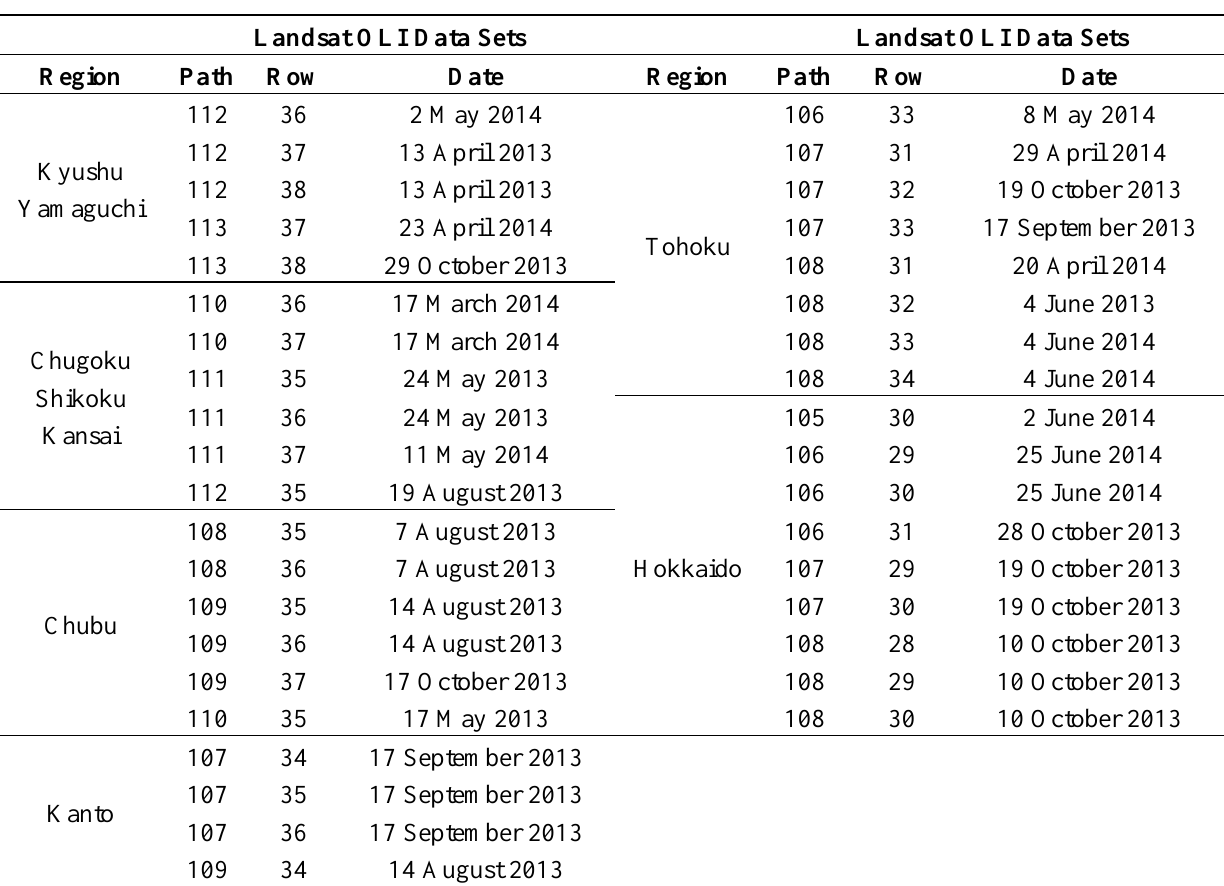
Table 1. Specification of the Landsat Imagery